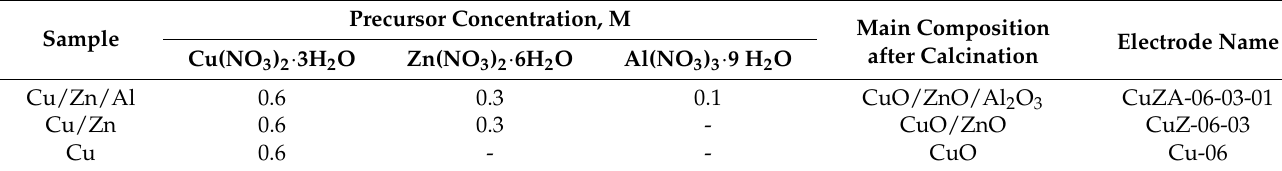
Table 1. Composition of the prepared ternary catalysts.